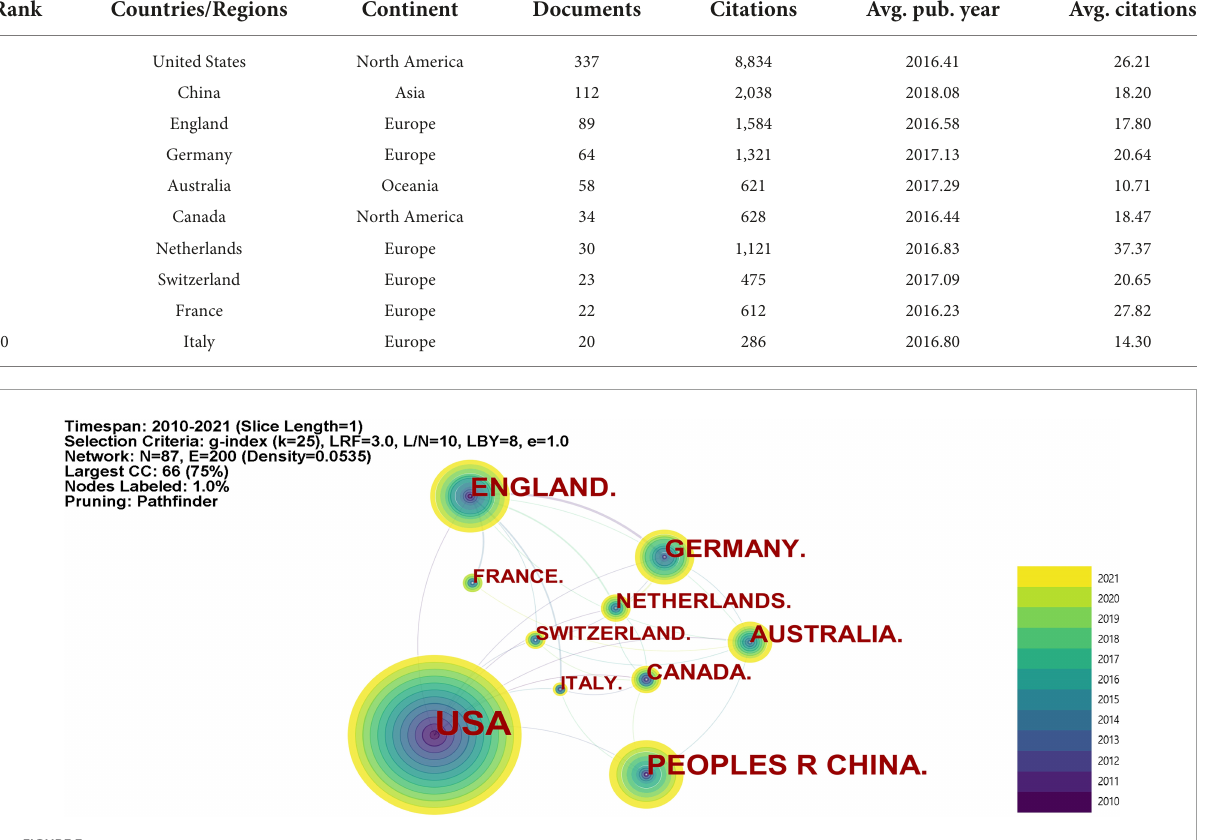
FIGURE3 Countries/regions collaboration network of financial decision making research.